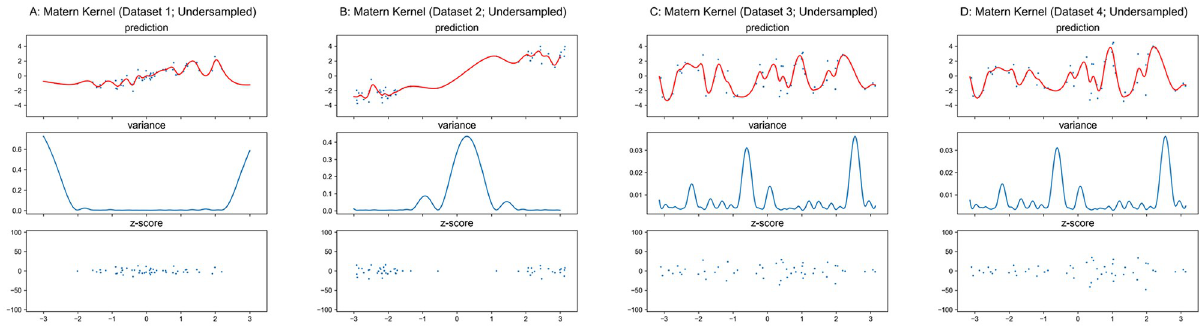
Fig 9. GPR with mate´rn kernel on undersampled datasets. Scales of Y-axis for variance plots are different.